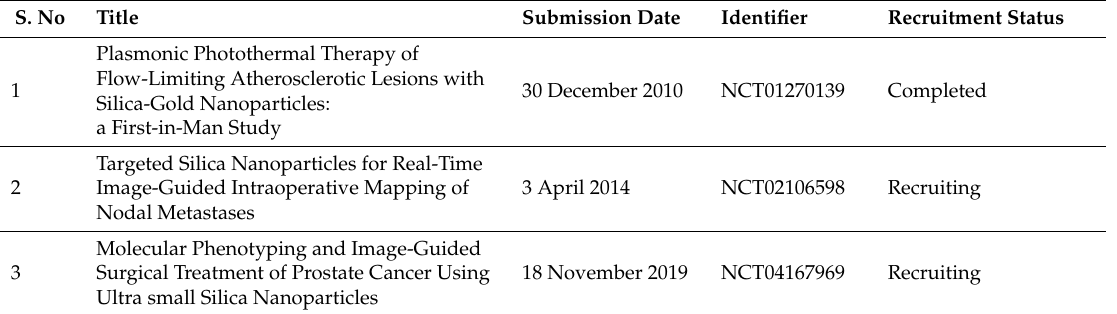
Table 1. Clinical trials on silica